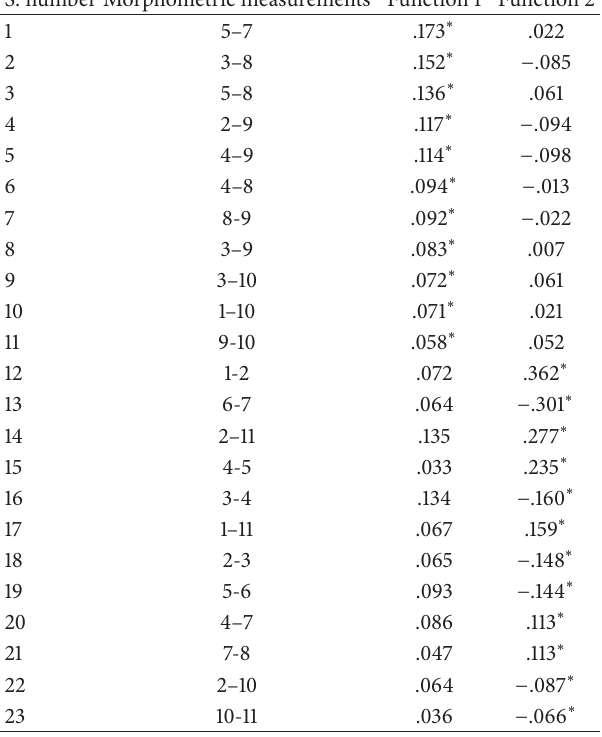
Table 3: Pooled within-groups correlations between discriminating morphometric measurements and standardized canonical discrim- inant functions. Variables ordered by absolute size of correlation within